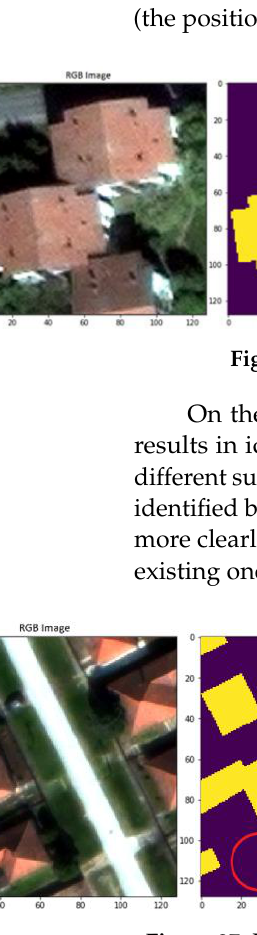
Figure 25. Comparison of the two classification models—misclassified pixels.